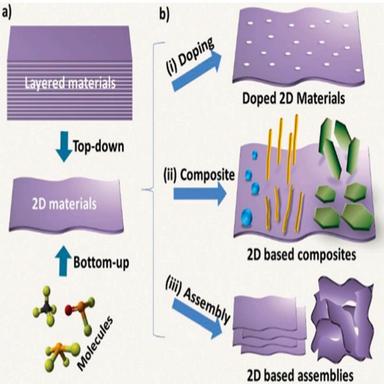
Schematic illustrations of top-down and bottom-up approaches for the formation of 2D materials (, Copyright (2020) The Royal Society of Chemistry.